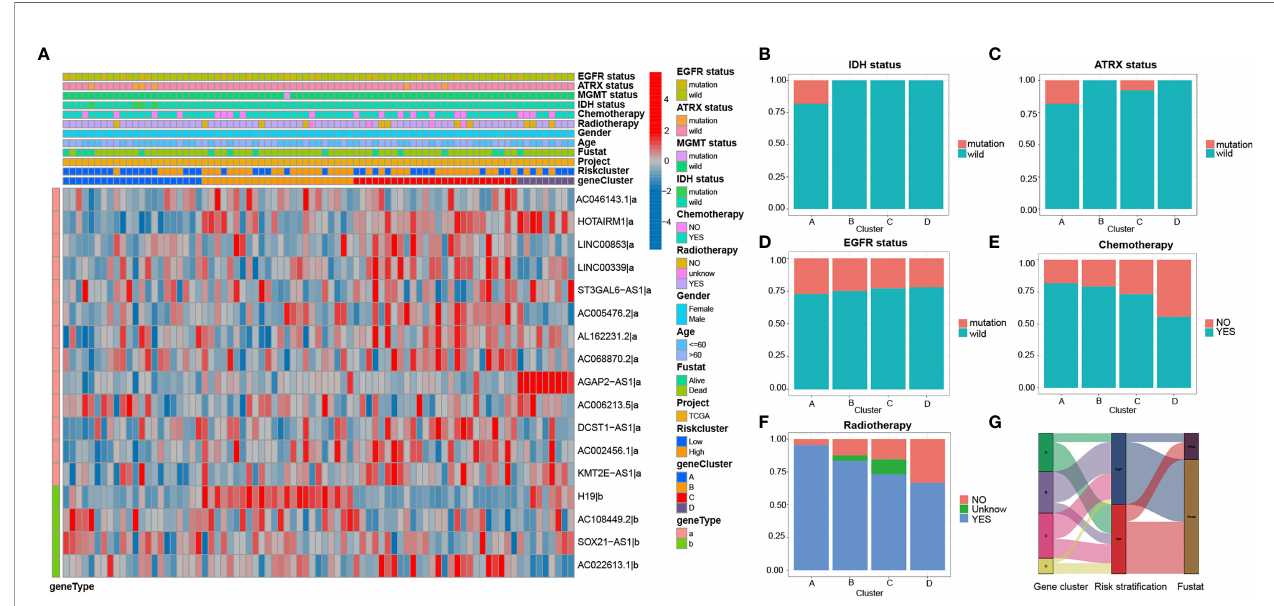
FIGURE 5 | Heatmap and clinicopathological features of four GBM subtypes (A) The heatmap and clinicopathological features of the 4 clusters based on the expression patterns of the 17 irlncRNAs in the training set. (B – F) Distribution ratio of IDH/ATRX/EGFR status and chemotherapy and radiotherapy in GBM subtypes. (G) Sankey diagram showing the prognosis of four GBM